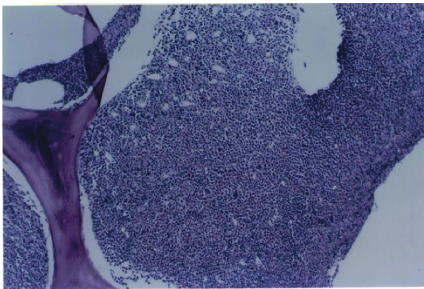
Figure 4: Bone marrow biopsy showing hyperplastic marrow with high M/E